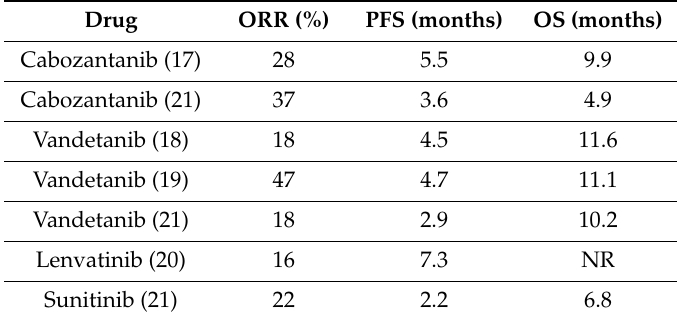
Table 1. Response rates separated by drugs as reported by each study in RET fusion positive non-small cell lung